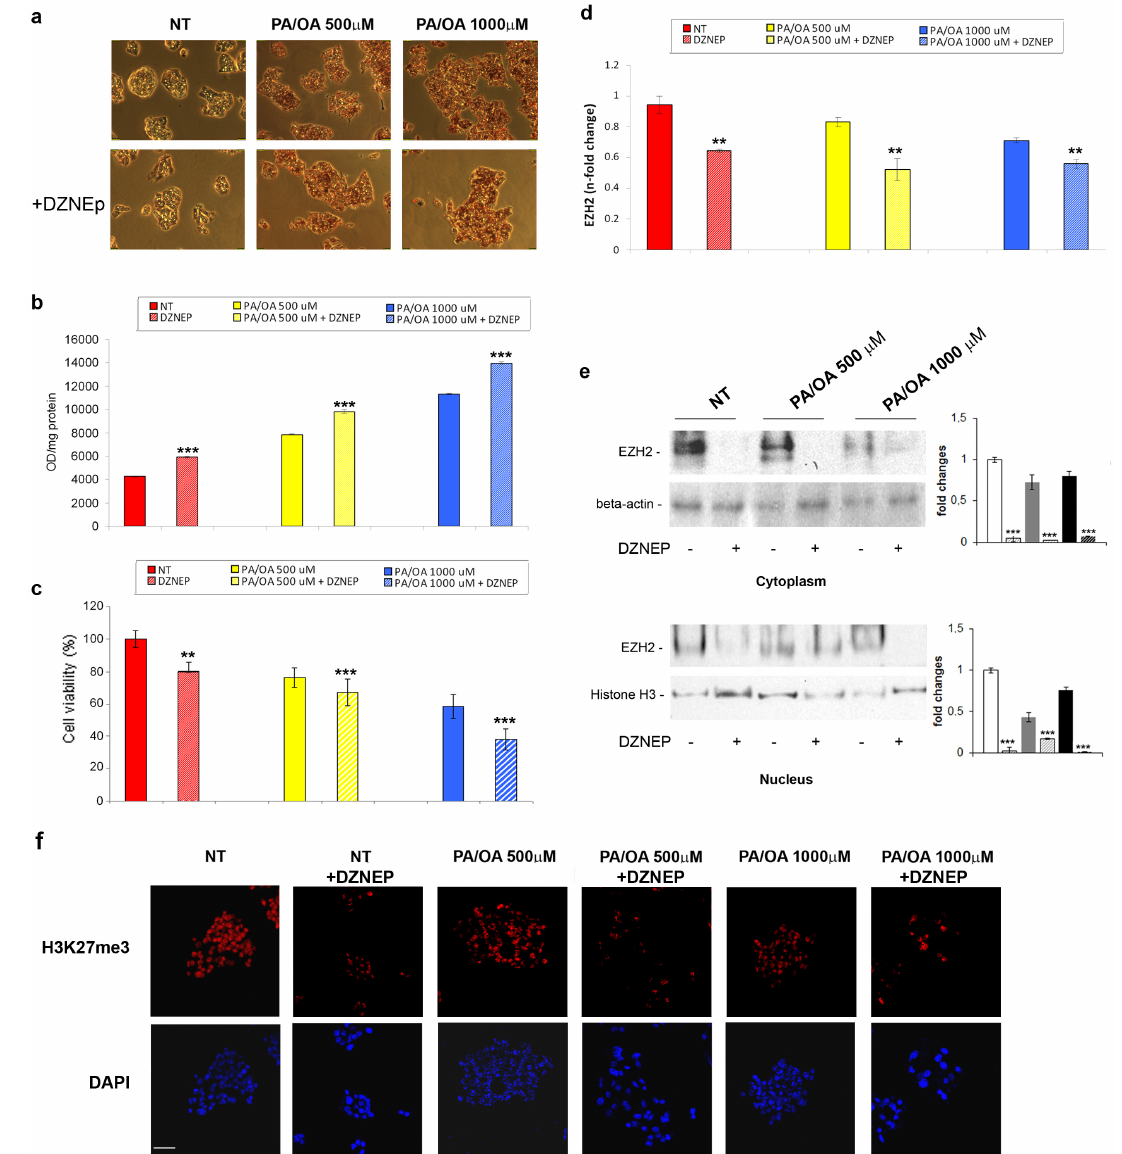
Figure 3. ( a ) Representative photomicrographs (200×) and ( b ) spectrophotometric quantification, expressed as optical density (OD)/mg protein of lipid accumulation by Oil-Red-O in the normal HepG2 cells or those treated with 500 or 1000 µM PA/OA for 24 h post DZNep pre-treatment. The histograms represent the mean ± SD of at least three independent experiments in triplicate. *** p < 0.001 vs . respective controls; ( c ) Cytotoxic effect of FFAs and/or DZNep on HepG2 cells was measured by Cell Proliferation Kit II (XTT). Data, referring to two independent tests, were normalized as % of untreated cells. ** p < 0.01 and *** p < 0.001 vs . control cells; ( d ) EZH2 mRNA expression levels and ( e ) representative western blotting of the total EZH2 protein levels in the FFA-treated or untreated HepG2 cells pre-exposed to DZNep. The histograms represent the mean ± SD of at least two independent experiments in triplicate. ** p < 0.01 and *** p < 0.001 vs . the respective controls; and ( f ) ( upper panel ) Immunofluorescence of H3K27me3 after previously described treatments, compared with non-treated cells (NT). ( lower panel ) DAPI was used to stain nuclei (Magnification 40×). Scale bar, 30